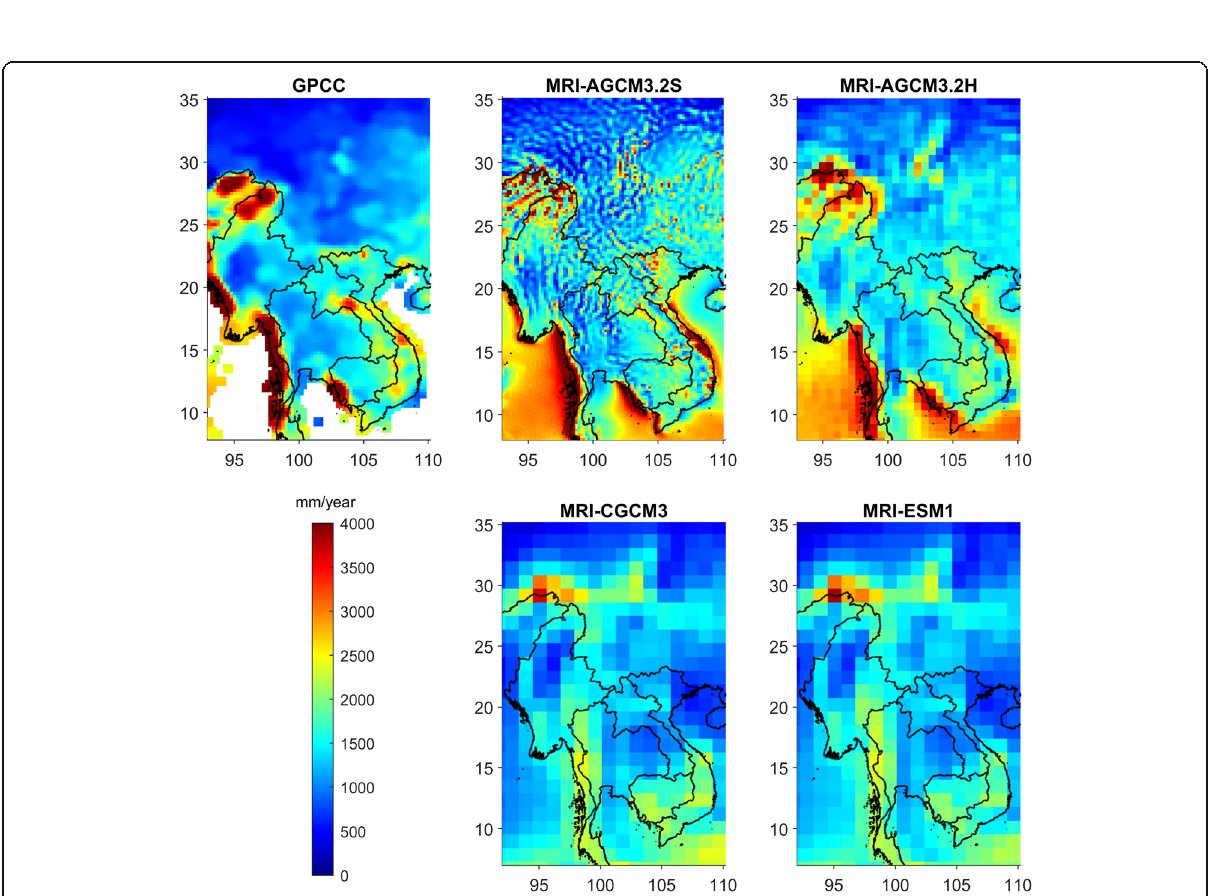
Fig. 13 Spatial distribution of annual precipitation of GPCC and four climate models (MRI-AGCM-3.2S, MRI-AGCM3.2H, MRI-CGCM3, and